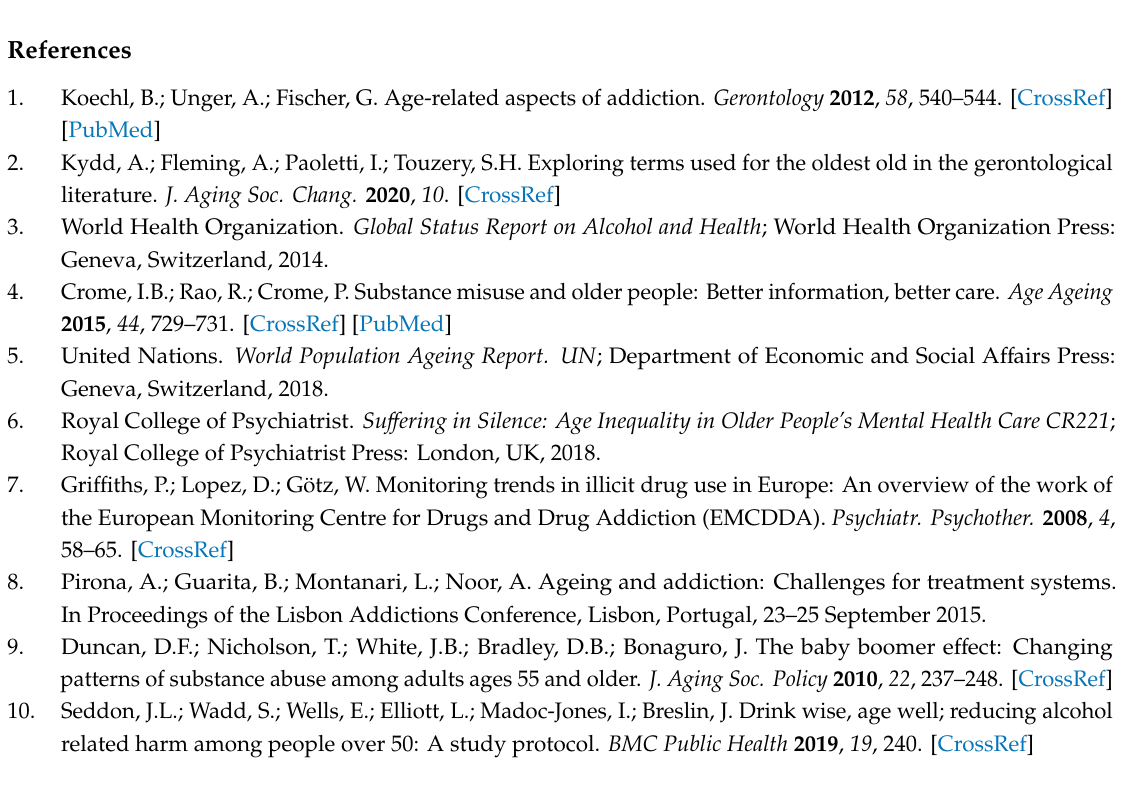
Table S1: Full search strategy, Table S2: The participants, interventions, comparisons, outcome, study design (PICOS) eligibility criteria (Joanna Briggs Institute, 2001), Table S3: MERSQI score assessment table, Table S4: Quality Assessment of RCT studies using